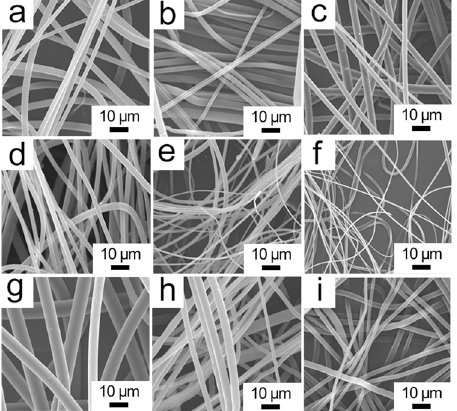
Figure 2. SEM images of melt electrospun fibers (( a – i ) (4% H201)/PLA, (4% H202)/PLA, (4%